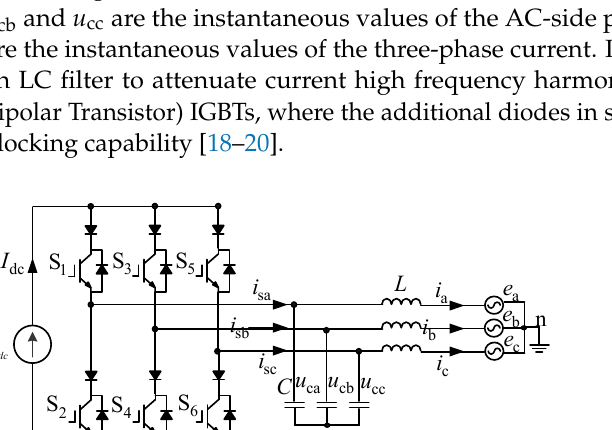
Figure 2. Schematic diagram of current source converter.